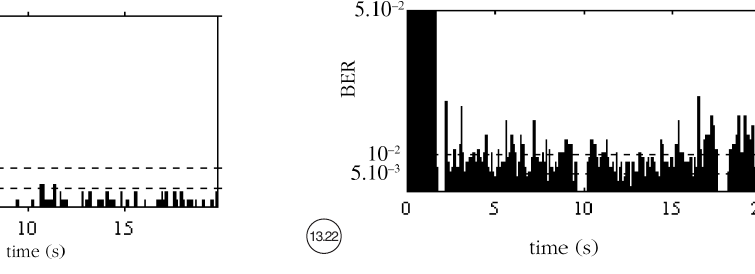
Fig. 13.21. Variations of BER. Fig. 13.22. Temporal variations of BER.